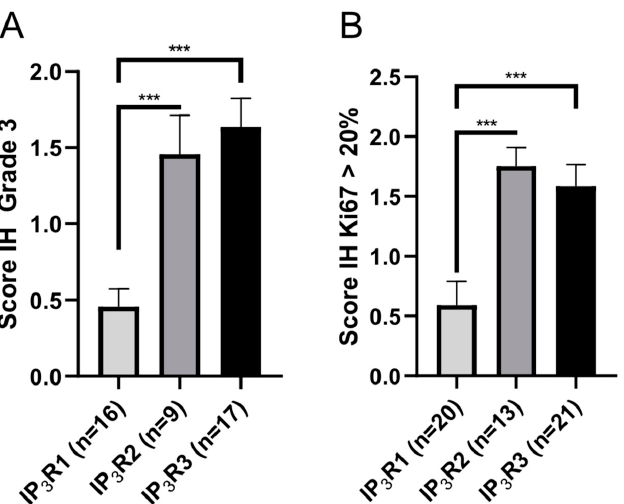
Figure 4. The IP 3 R IH expression scores in SBR grade 3 IBC-NST ( A ) and IBC-NST with a high Ki67 proliferation index ( B ). *** p < 0.001.